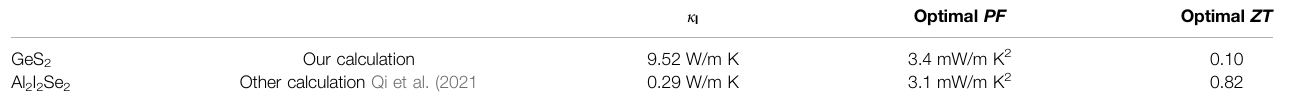
TABLE 1 | Comparison of calculated thermoelectric parameters ( κ l , optimal PF , and ZT ) at 300 K between GeS 2 and Al 2 I 2 Se 2 monolayers.